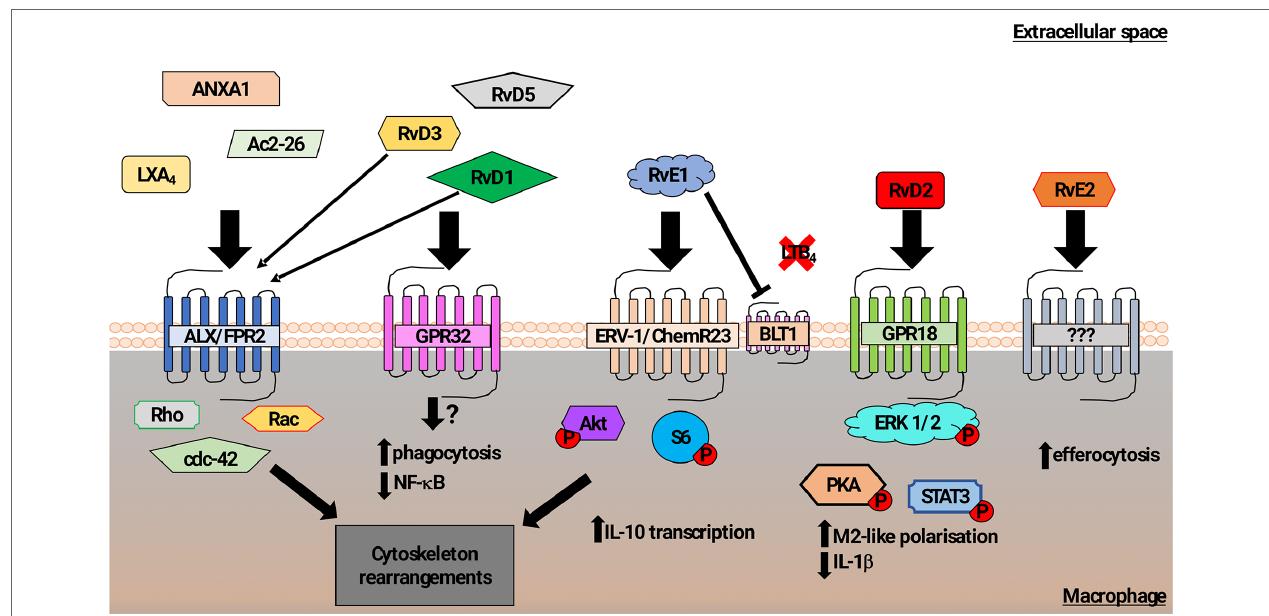
FIGURE 1 | Schematic representation of mechanisms promoting macrophage phagocytosis of AC by lipid mediators. In addition to a role in recognition of N-formylated peptides that are generated during bacterial and mitochondrial protein synthesis, the formyl peptide receptor 2 (ALX/FPR2) also binds to Lipoxin A4, Annexin A1, and Ac2-26 (N-terminal part of Annexin A1) to increase macrophage phagocytosis of AC (Godson et al., 2000; Maderna et al., 2002; Scannell et al., 2007; Maderna et al., 2010). Signaling following ALX/FPR2 binding by these ligands was shown to induce rearrangements in the actin cytoskeleton in a Rho, Rac, and cdc42-dependent manner. GPR32 is thought to be the main receptor for the resolvin D family members 1, 3, and 5 (RvD1,3,5) that acts to promote phagocytosis of AC and reduce NF- κ B activity. RvD1 and RvD3 were also found to bind ALX/FPR2 with high affinity and induce macrophage phagocytosis (Arita et al., 2007; Krishnamoorthy et al., 2010, Krishnamoorthy et al., 2012; Dalli et al., 2013b). The resolving E family member 1 (RvE1) increased macrophage phagocytosis of AC via binding to ERV-1/ChemR23. Phosphorylation of Akt and S6 proteins induced cytoskeletal rearrangements as well as promotion of transcription of the anti-inflammatory cytokine IL-10 (Laguna-Fernandez et al., 2018). RvE1 can also competitively bind to the leukotriene B4 receptor BLT4, acting to reduce pro-inflammatory signaling (Arita et al., 2007; Ohira et al., 2010; Laguna-Fernandez et al., 2018). Resolvin D2 (RvD2) mediated activation of GPR18 induced an M2-like macrophage phenotype exhibiting increased phagocytosis via a mechanism involving phosphorylation of the ERK, PKA, and STAT3 (Fredman and Serhan, 2011; Dalli et al., 2013b). Although resolving E2 (RvE2) was also reported to induce macrophage phagocytosis, the pathway that controls this effect has not been clearly identified (Oh et al.,